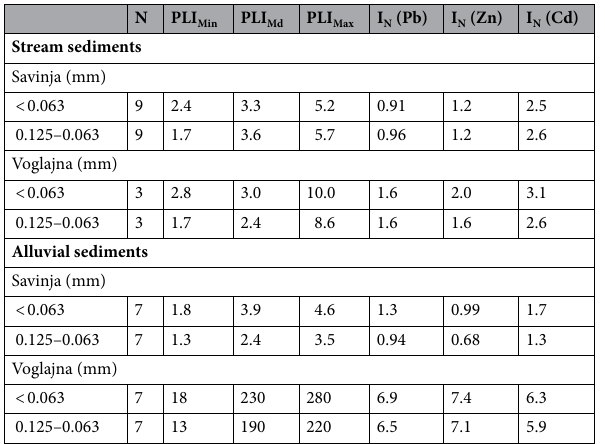
Table 4. Calculated PLI and I N indexes for stream and alluvial sediments downstream the dominant source of contamination for both fractions. N number of samples considered, Min minimum value, Md median, Max maximum